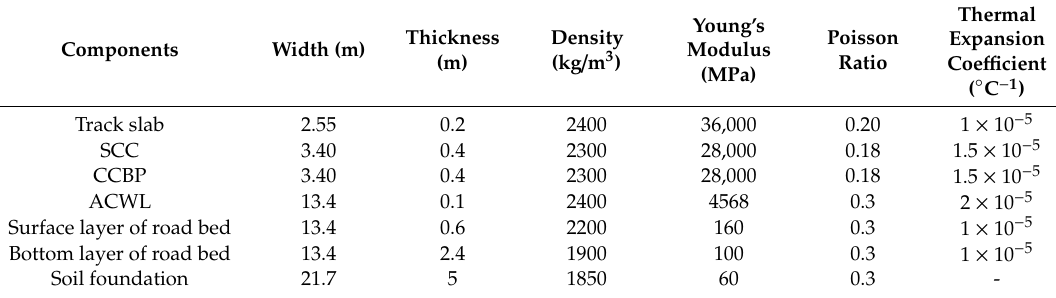
Figure 6. Sub-rail infrastructure cross-sectional picture. SCC: self-compacting concrete. Table 3. Geometries and material parameters of ballastless track system.